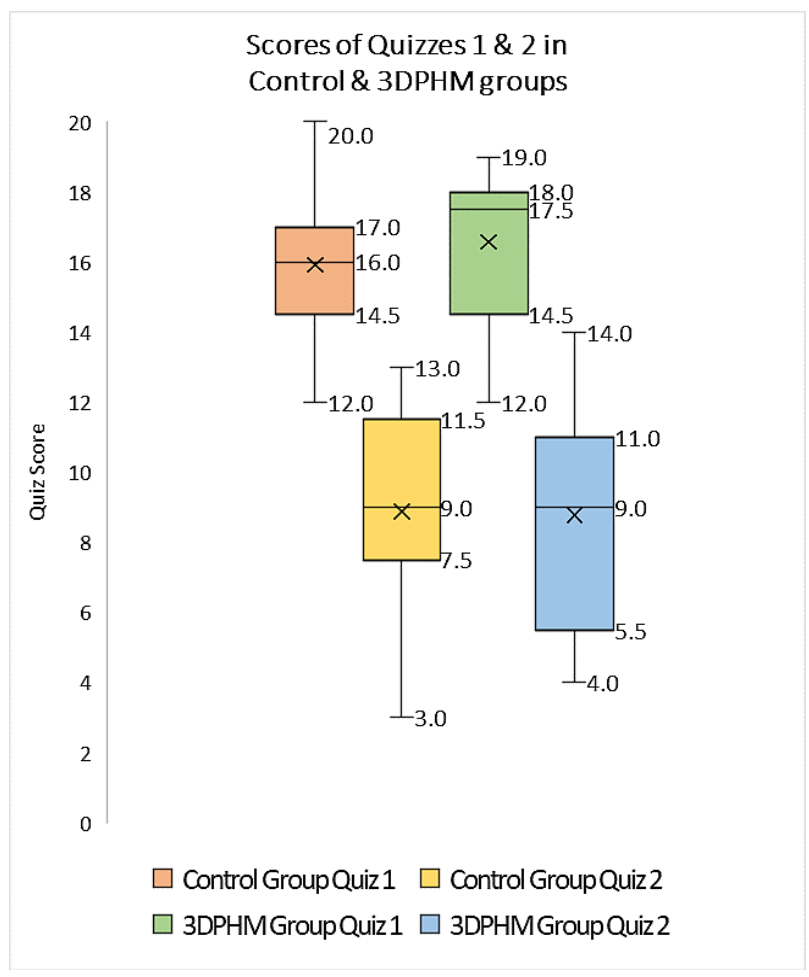
Figure 7. Boxplot showing the scores (out of 20) of quizzes one and two in 3D printing and control groups for 3DPHM-3D printed heart model. Reprinted with permission under the open access from Lau and Sun [25].